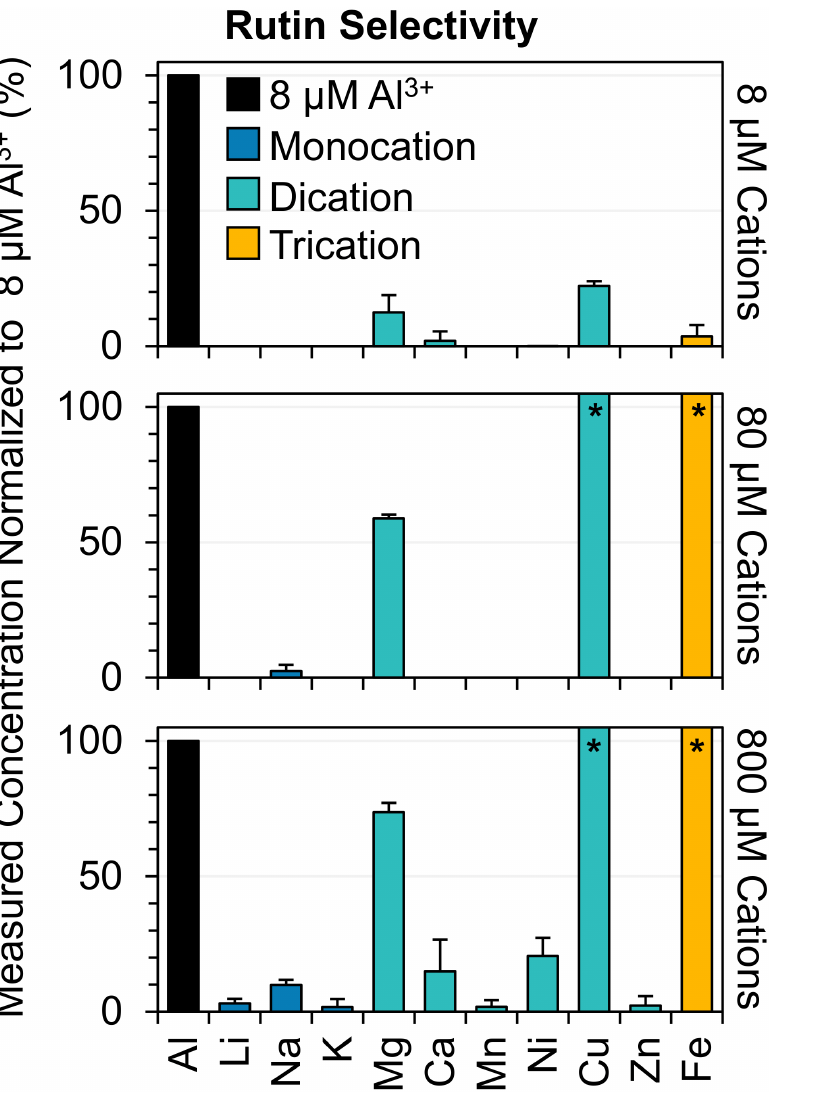
Figure 4 Selectivity of rutin to a series of mono-, di-, and tri-cations. Demonstrates the assay response in percent of mono- (dark blue), di- (light blue), and tri-cations (orange) with increasing concentration with respect to the response of the highest detectable aluminum concentration (8 µ M). The A 410nm /A 355nm ratios of the cations were measured and converted to a concentration via an aluminum calibration curve and then normalized to the maximum concentration of aluminum (8 µ M) within the linear range of the assay. Note that the A 410nm /A 355nm signal of the cations may be due to either rutin complexation or chro- maticity resulting from the cation solutions. The asterisks (*) for copper and iron cations denote that the measured concentration exceeded the linear range of the assay ( i.e., measured concentrations are higher than 8 µ M of Al 3 + ). The bars represent the average of n = 3 measurements and the error bars are the stan- dard deviation of n = 3